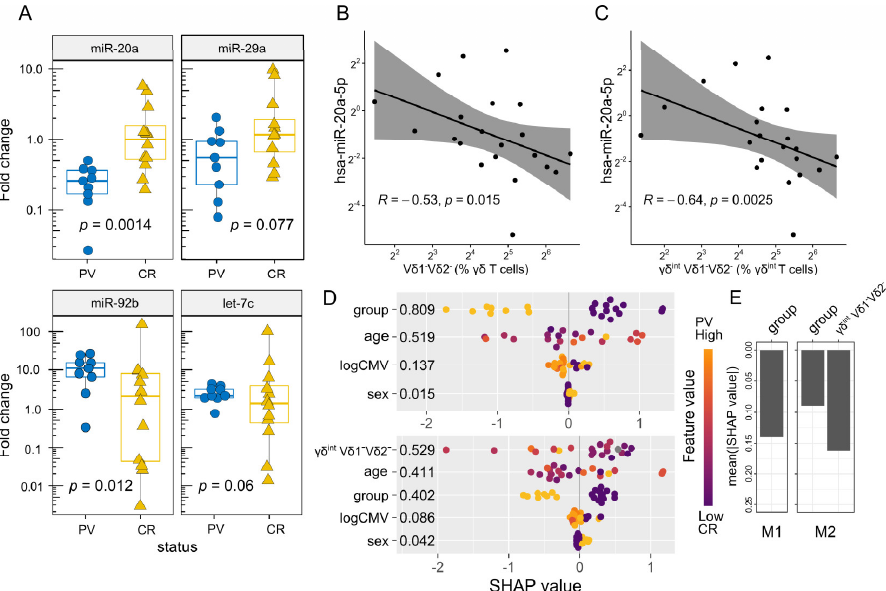
Figure 2. Box–whisker plots ( A ) highlighting the miRNA expression (fold change, log2 scale) in each donor (FACS-sorted γδ blood T cells). Horizontal lines represent the median with the interquartile range. p -values are from a two-tailed Mann–Whitney U-test. Scatter plot representing ( B ) a relation between the hsa-miR-20a-5p expression (MIMAT0000075, fold change, log2 scale) and ( C ) the γδ blood T-cell composition (flow cytometry). R denotes the Spearman’s correlation coefficient; each dot represents one donor. The black line represents a linear model fit (least squares method), whereas the shaded region indicates the 95% confidence interval. Each dot represents one donor.